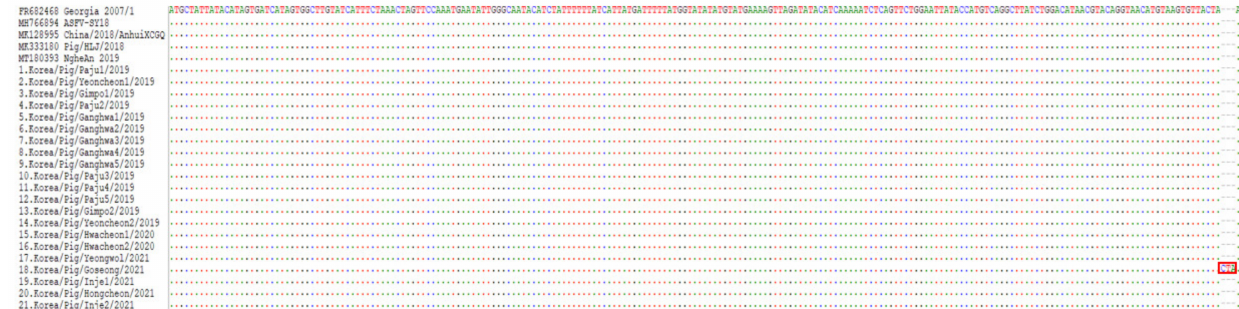
Figure 4. Analysis of X69R of the J286L region in ASFV strains isolated in pig farms in South Korea during 2019–2021. The 18th isolate, designated as Korea/Pig/Goseong/2021, contains three nucleotide (CTA) insertion on the 209th position of X69R in the J286L region (red rectangle), leading to the addition of one tyrosine